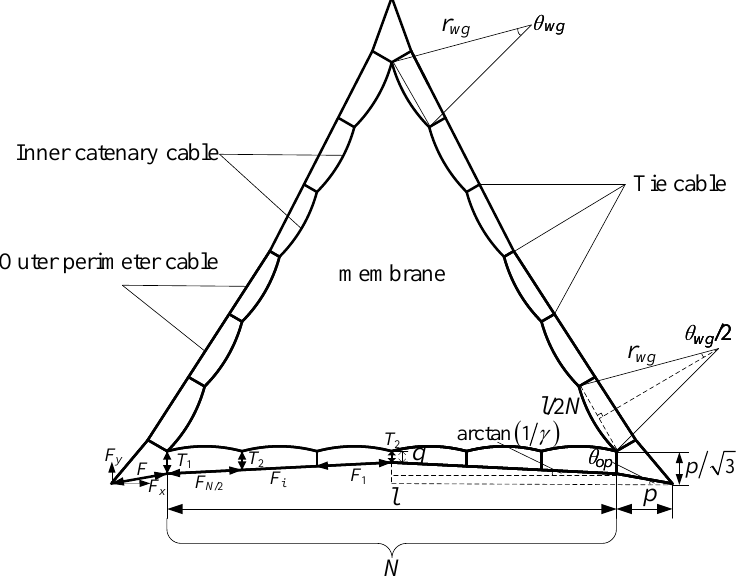
Figure 4. Web-like tensioned membrane